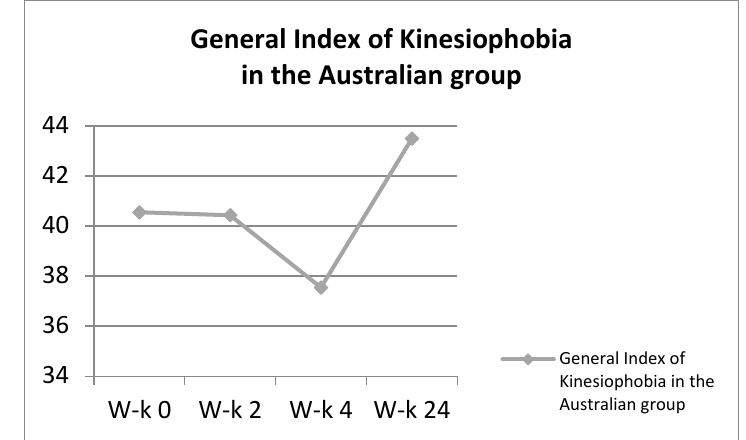
Figure 6. General Index of Kinesiophobia in the Australian group.